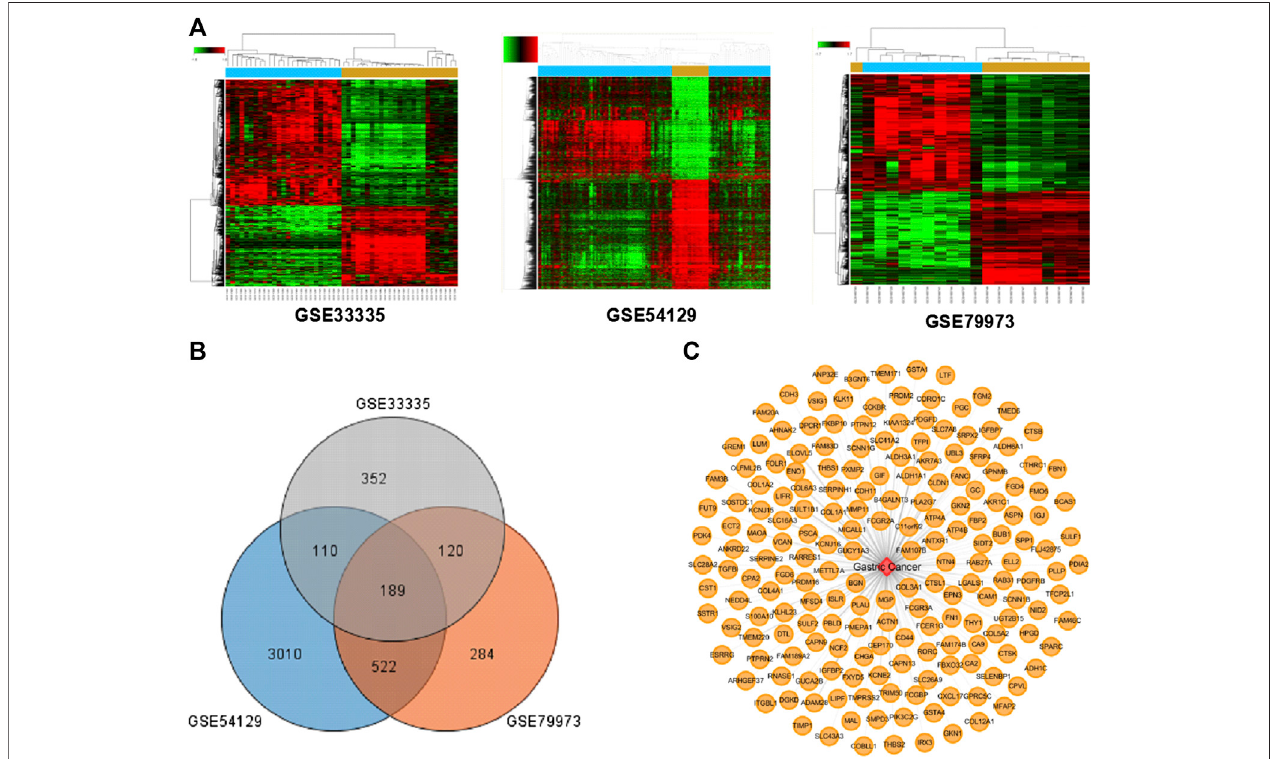
FIGURE 2 | The known GC-related targets were obtained from the Gene Expression Omnibus (GEO) database. (A) Three heat maps from GEO chips, including GSE33335, GSE54129, and GSE79973. (B) The Venn diagram of 189 common GC-related targets from three GEO chips. (C) Construction of the GC-related targets